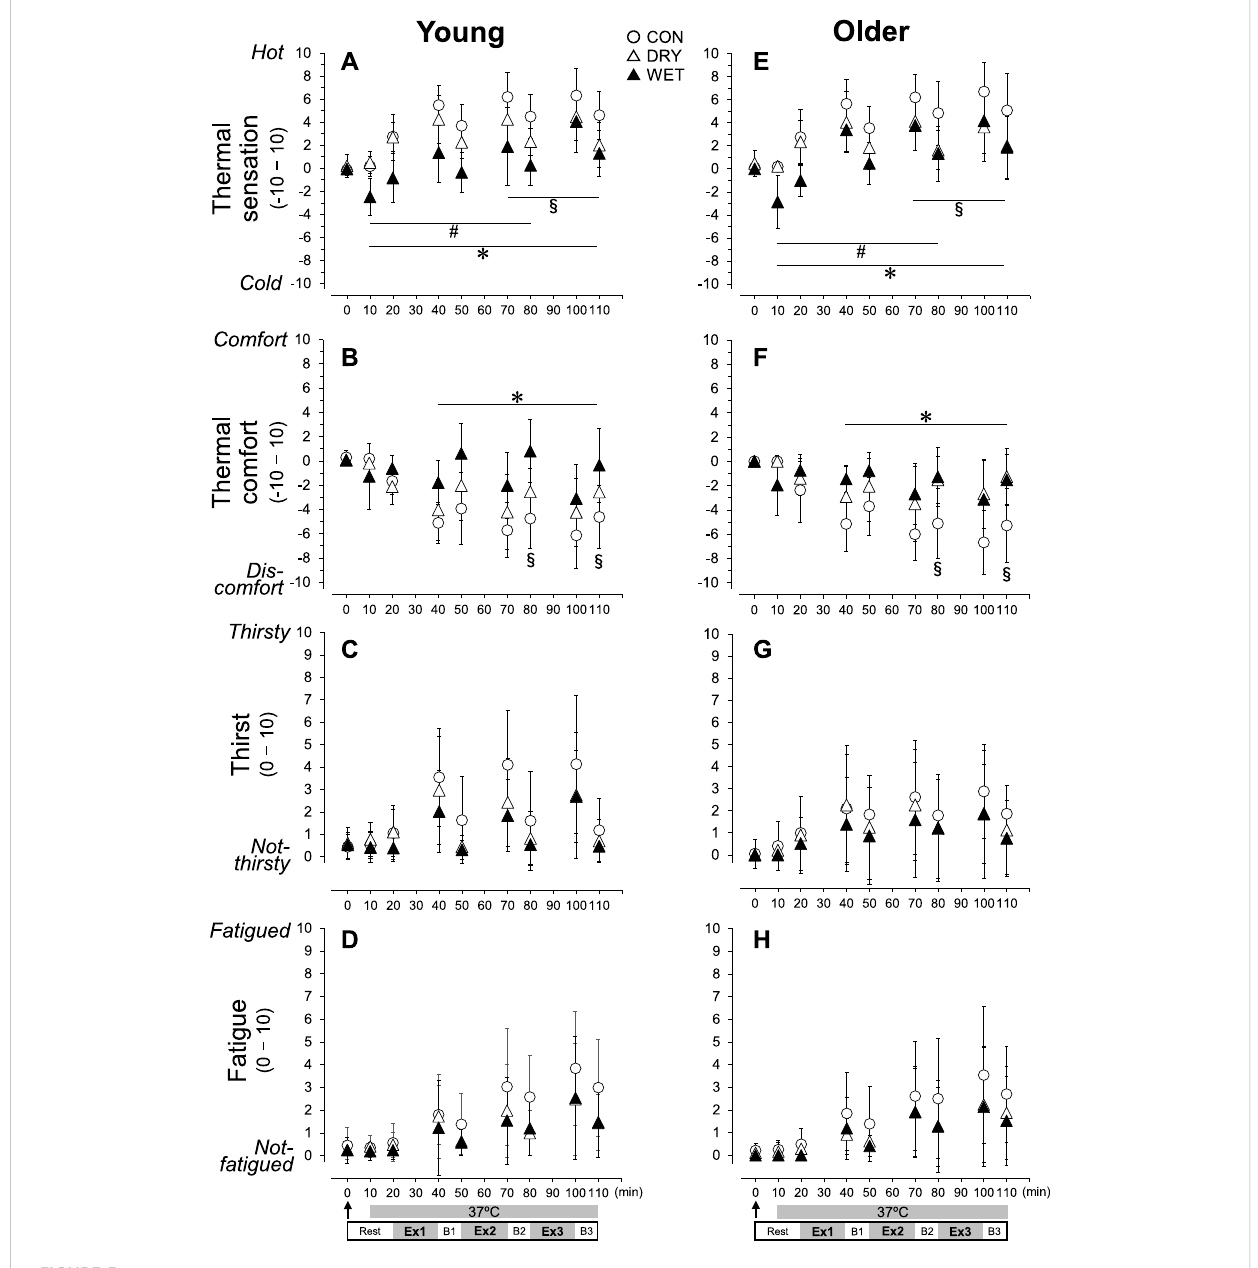
FIGURE 5 Perceptual responses of thermal sensation (A, E) , thermal comfort (B, F) , thirst (C, G) , and fatigue (D, H) during three bouts of intermittent exercise (Ex1 – 3) in hot conditions (37 ° C, 50% RH) interspersed by three breaks (B1 – 3) in the young (left) and older (right) groups while wearing a dry inner t-shirt without ventilation garment fanning in the control (CON, open circles), a dry inner t-shirt with ventilation garment fanning (DRY, opened triangles), and a wettedinnert-shirtwithventilationgarmentsfanning(WET,closedtriangles).Thearrowindicatesthestartoffanning(DRY)andwetting andfanning (WET).*Signi fi cantlydifferentforCONvs.WETtrial, p < 0.05.#Signi fi cantlydifferentforDRYvs.WETtrial, p < 0.05.§Signi fi cantlydifferentforCONvs.DRY trial, p < 0.05. Data are expressed as the mean ± SD for eight